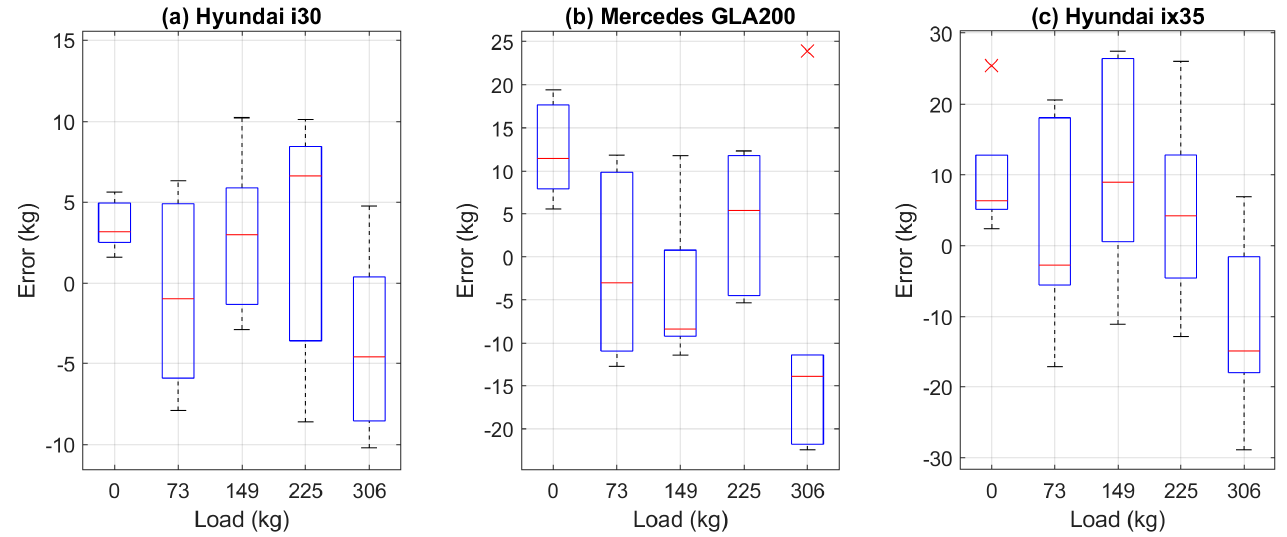
Figure 6. Measurement load error for test cars. On each box, the central red mark indicates the median, and the bottom and top edges of the box indicate the 25th and 75th percentiles, respectively. The whiskers extend to the most extreme data points not considered outliers, and the outliers are plotted individually using the ‘×’ symbol [28].